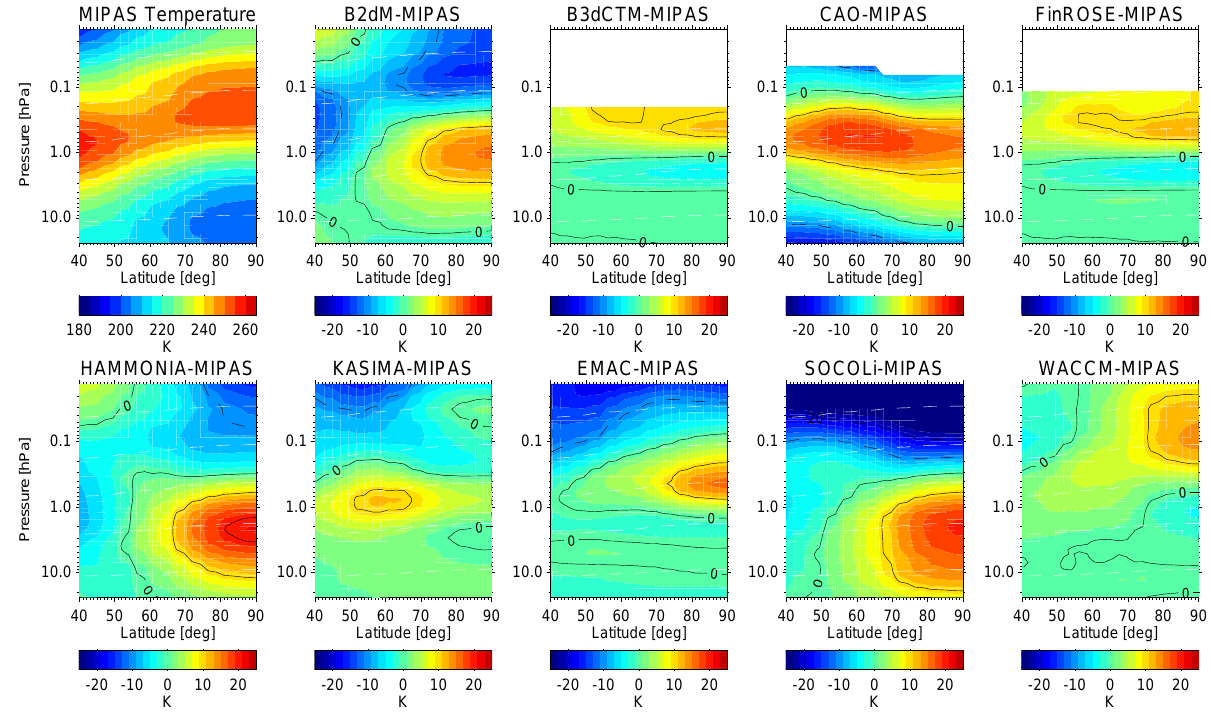
Fig. 7. Observed and modeled temperature zonal mean distributions at 40–90 ◦ N averaged over the period 29 October to 4 November 2003.